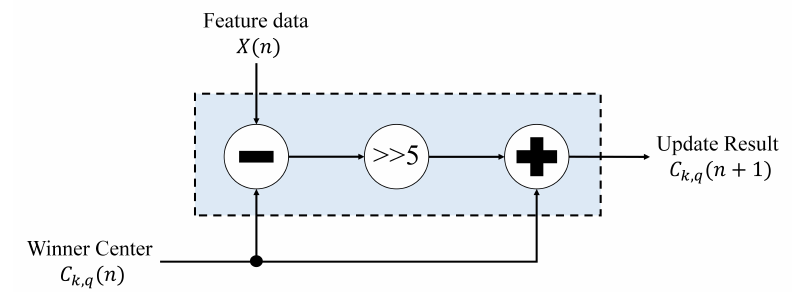
Figure 10. The architecture of winner update unit. The value of learning rate is η = 2 − 5 in the